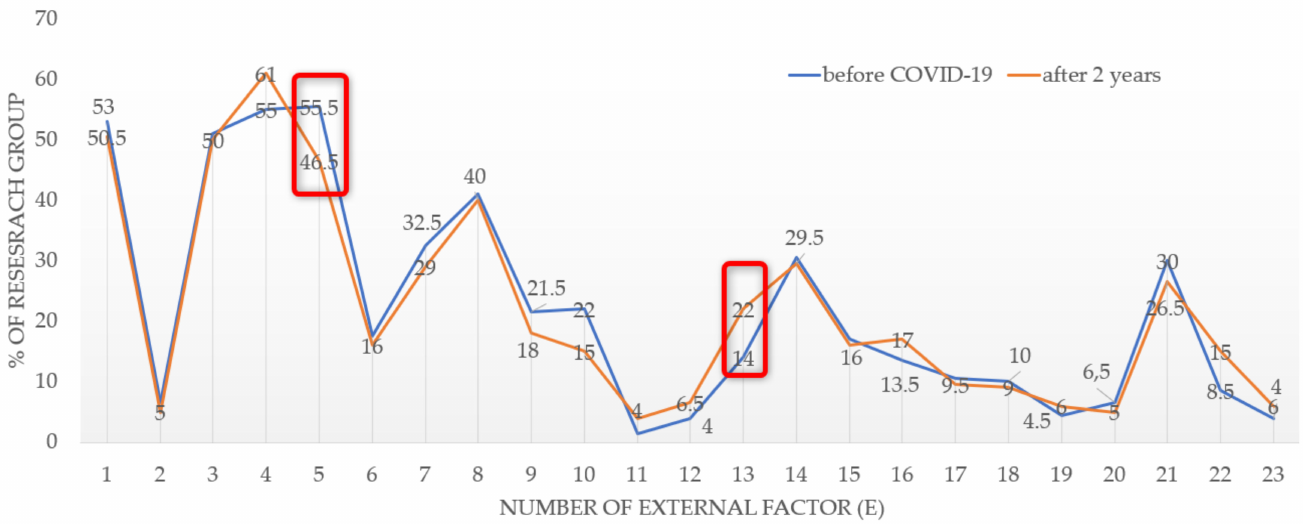
Figure 4. Changes in preferences in the residential location attributes after two years of COVID-19. Source: own